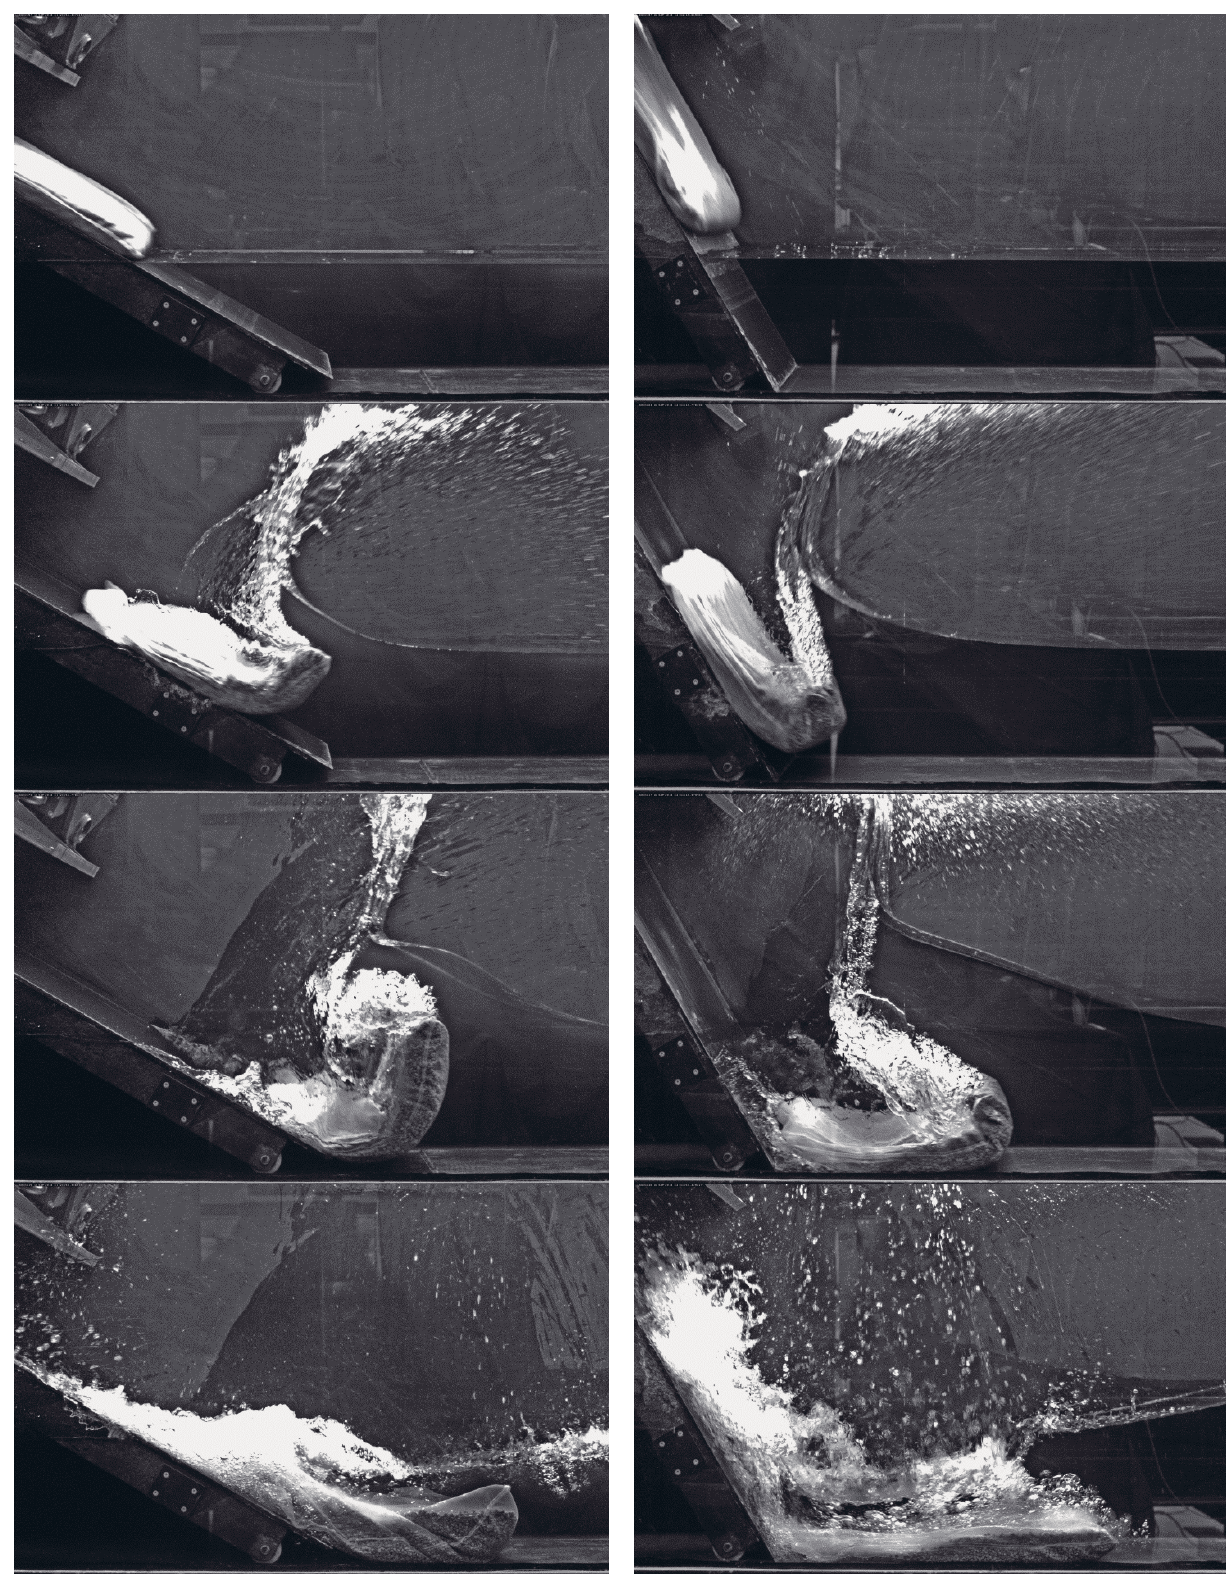
Figure 3. Photographs at various stages of wave generation process with mesh-packed slides. Left column: α = 30° with F = 2.27, S = 0.23, M = 0.45, and P = 0.84 at t = 0.00, 0.14, 0.34, and 0.90 s. Right column: α = 60° with F = 3.03, S = 0.21, M = 0.45, and P = 0.90, at t = 0.00, 0.11, 0.31, and 0.76